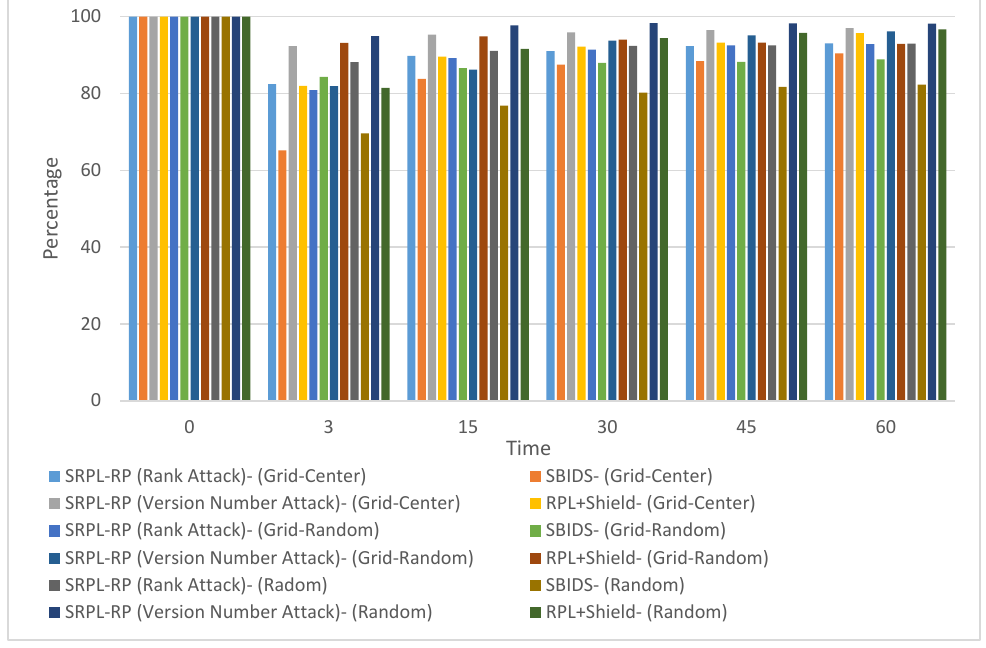
Figure 6. Accuracy Rate (AR) Comparison Three Topologies. Table 12. Accuracy Rate (AR) Comparison Grid-Center Topology.